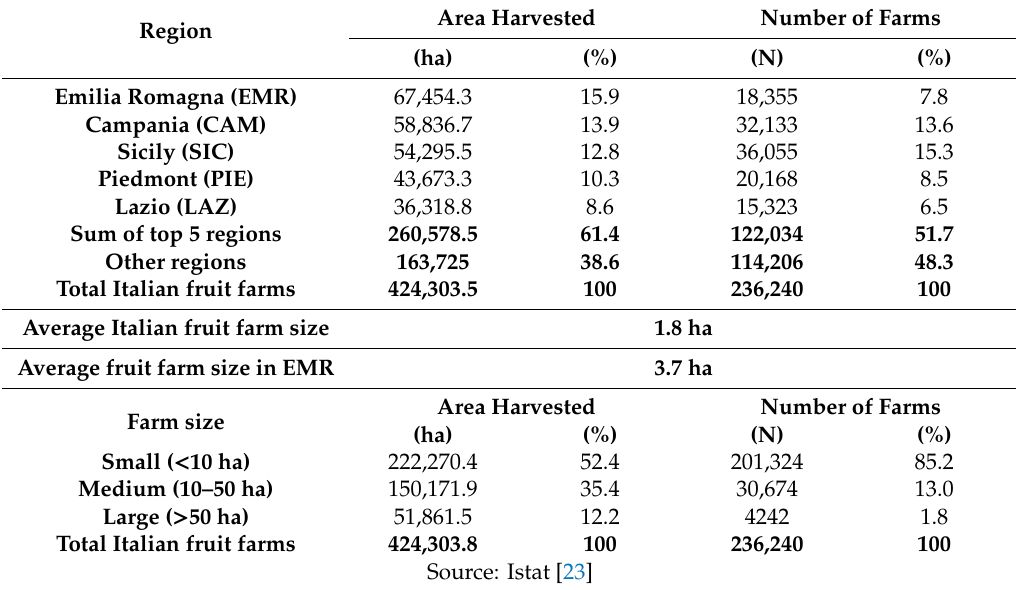
Table 1. Top 5 regions in fruit production and farm size in Italy. Area Harvested Region